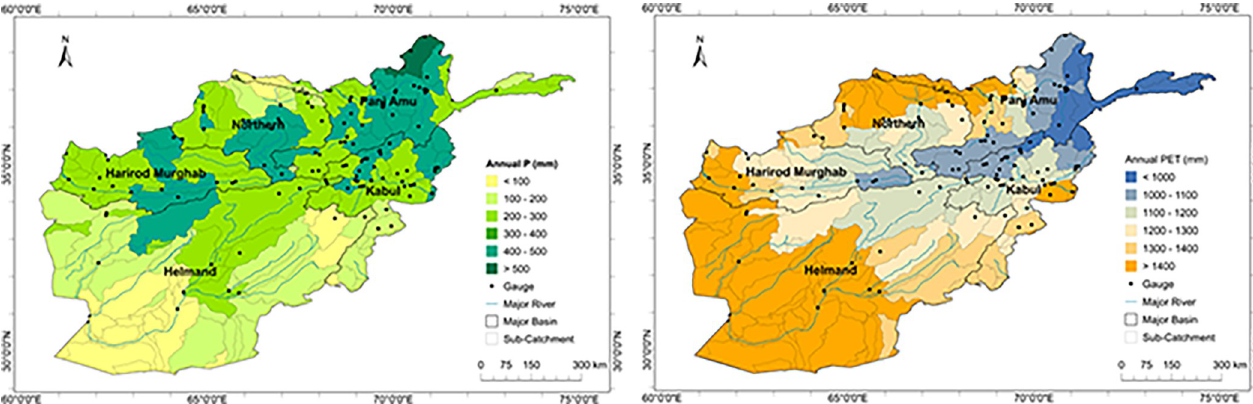
Fig 3. Mean annual P (a) and PET (b) at sub-catchment scale over the period 1980–2017.